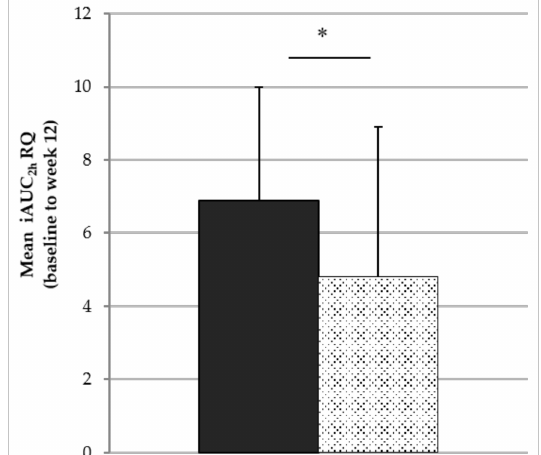
Figure 4. Mean iAUC for RQ of the visits at baseline and weeks 4, 8, and 12 for isomaltulose (grey bar) and sucrose (black bar) considering 2 h post-breakfast consumption (0–120 min). * Independent sample t-test: p <